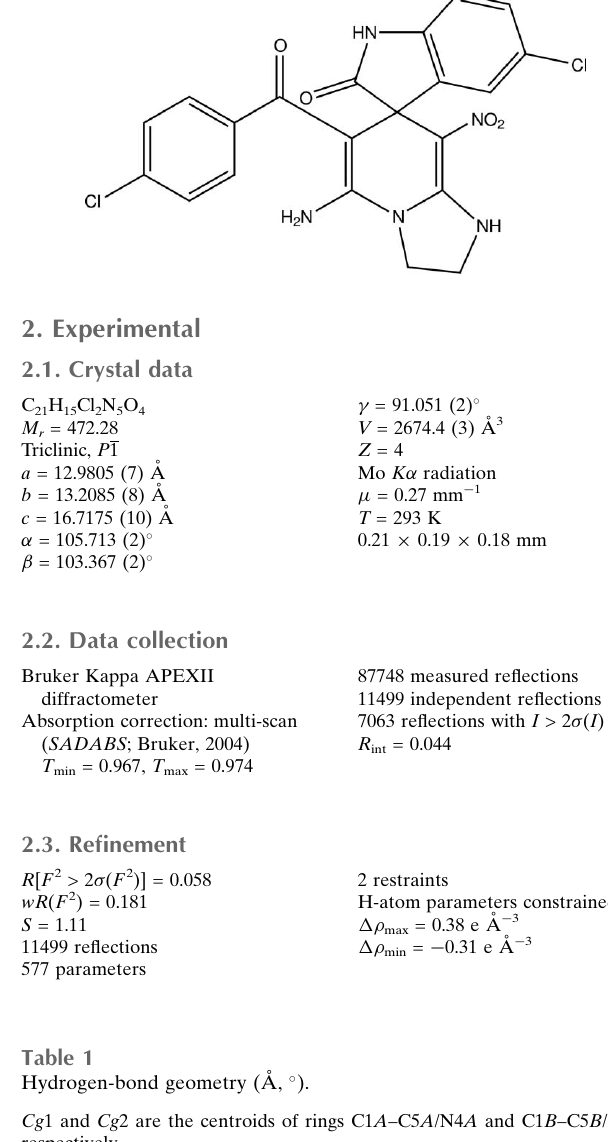
Hydrogen-bond geometry (A˚ , (cid:2)